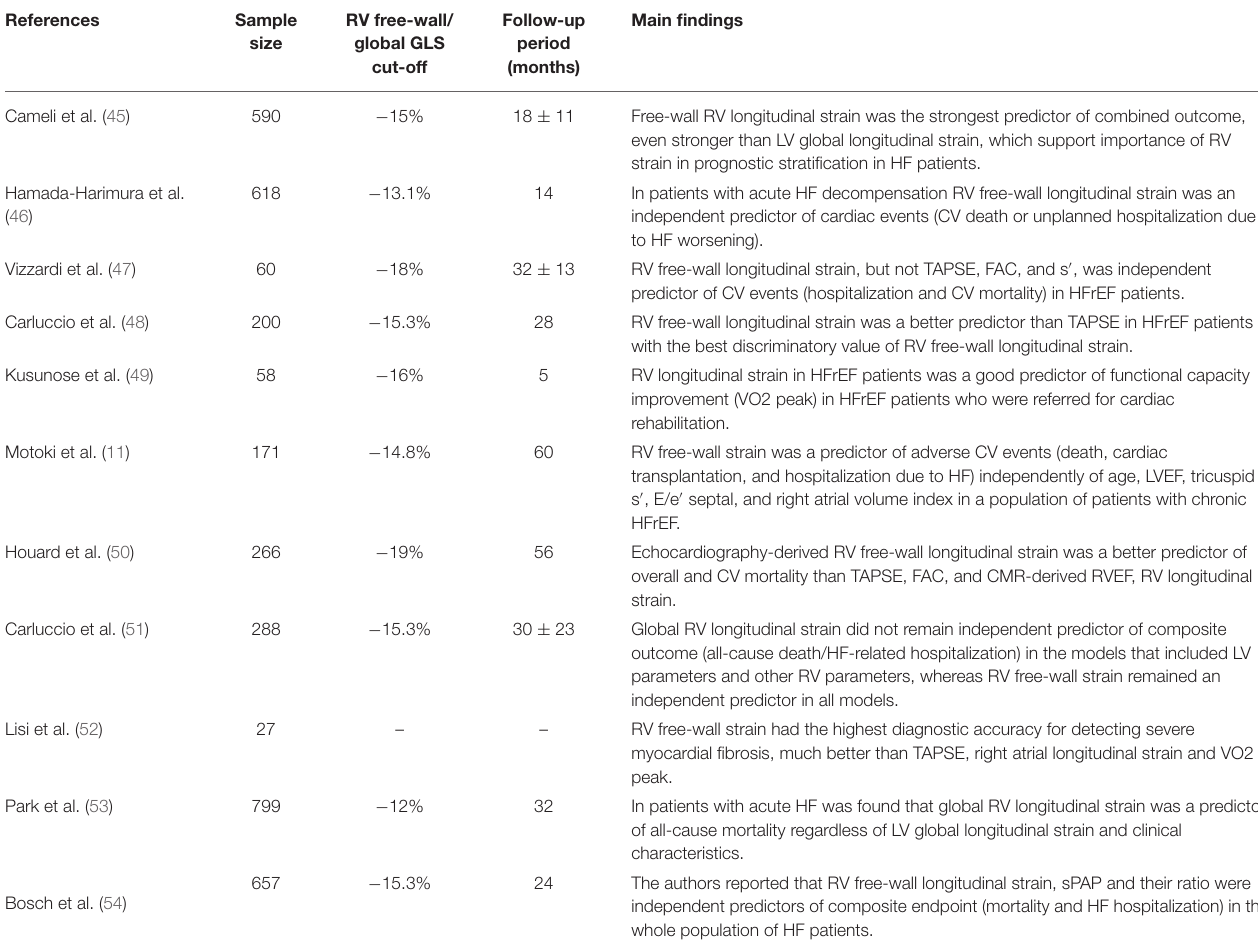
TABLE 3 | Predictive value of RV longitudinal strain in heart failure.